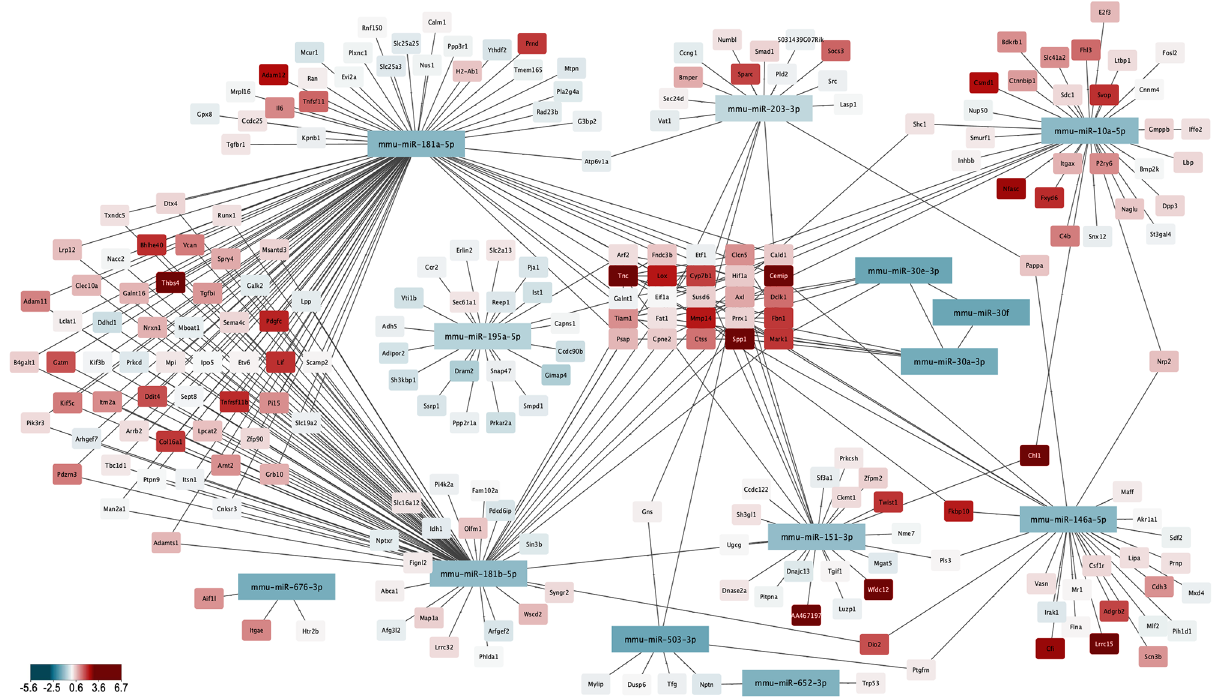
Figure 6. Network of all conserved downregulated miRNAs and their predicted DE targets. MicroRNAs were selected as described in Fig. 5d, with additional nodes selected as first neighbors of the selected miRNAs. Color scale of the node is the log2-fold change at day 21 in the AAV6.2-TGFβ1 model, with red indicating upregulation, and blue indicating downregulation. MiRNAs are represented as large rectangles, and mRNAs as small rectangles. Image created with Cytoscape